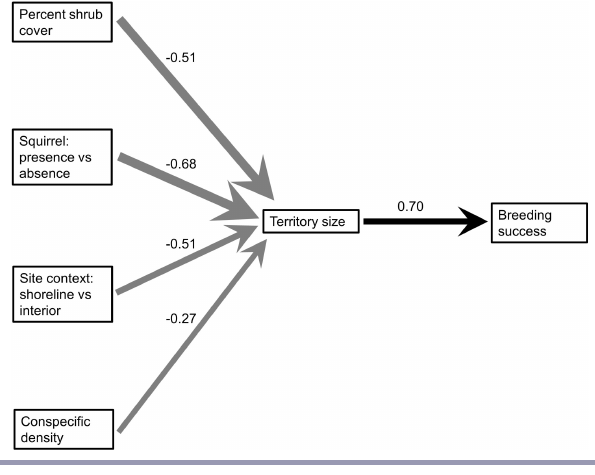
Fig. 2 . Final path model from AIC model selection procedure depicting variables affecting territory size and breeding success for Canada Warblers ( Cardellina canadensis ) in Western Canada. Arrows are scaled in size relative to the increase in the AIC statistic when the parameter in question is removed from the top model. Effect sizes are based on standardized continuous covariates. Negative effects are represented by the grey arrows as well as the negative sign associated with each parameter estimate.